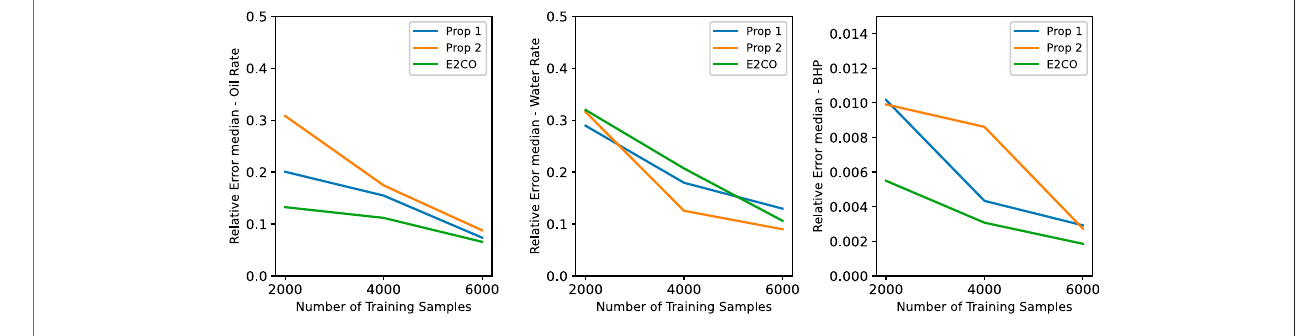
FIGURE 14 | Validation set error for different training set